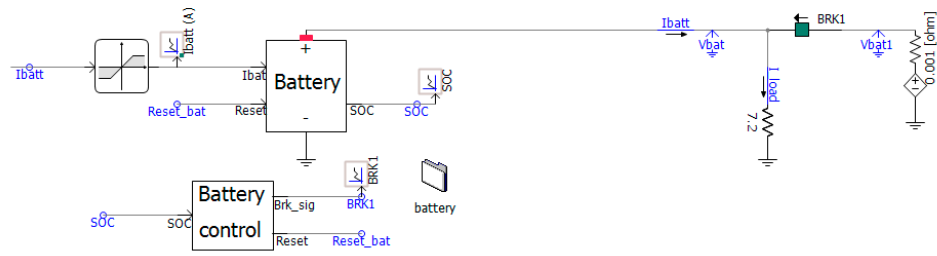
Figure 11. Simulation model of energy storage system.